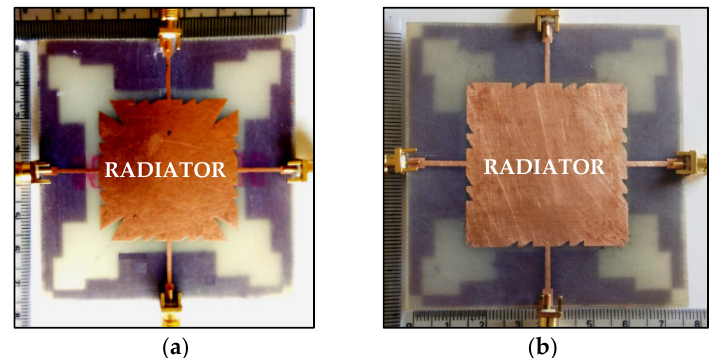
Figure 16. ( a ) Four ports multi-cut shared radiator and stepped ground [78], ( b ) Four ports multi-cut shared radiator and stepped ground [79].